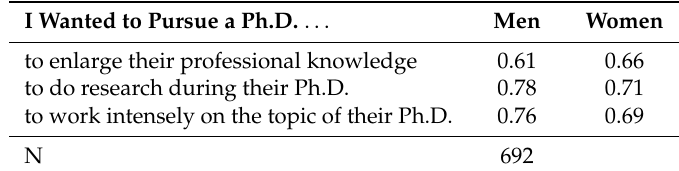
Table A4. Intrinsic Research Motivation: Factor Loadings of